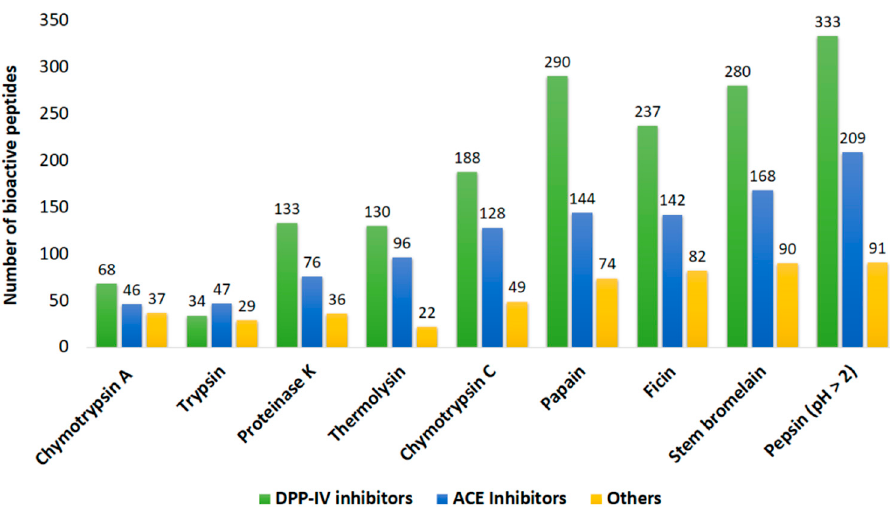
Figure 3. Total number of bioactive peptides released in silico by commercial enzymes through BIOPEP-UWM’s “Enzyme Action” tool (accessed on 6 March 2019). Other activities include antiamnestic, antibacterial, antioxidative, antithrombotic, neuropeptide, renin inhibitor, immunomodulating, stimulating, regulating, alpha glucosidase inhibitor, and activating ubiquitin-mediated proteolysis. DPP-IV: dipeptidyl peptidase IV.